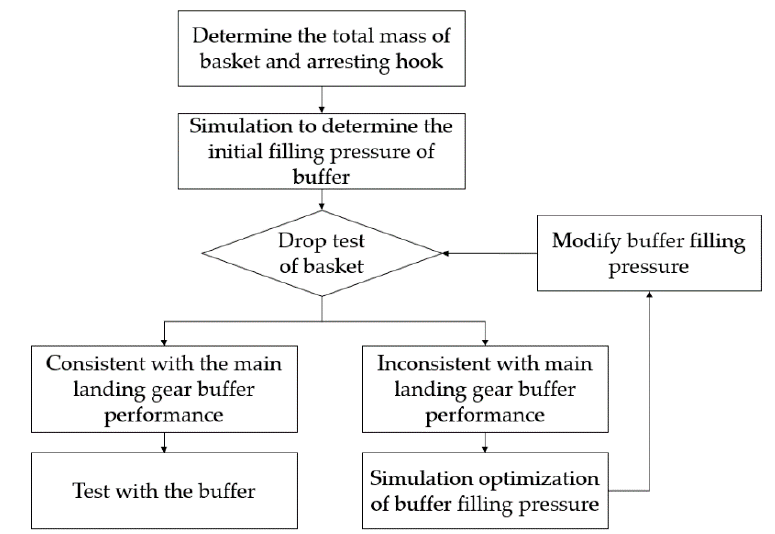
Figure 5. Flow diagram of determination of damper filling parameters.